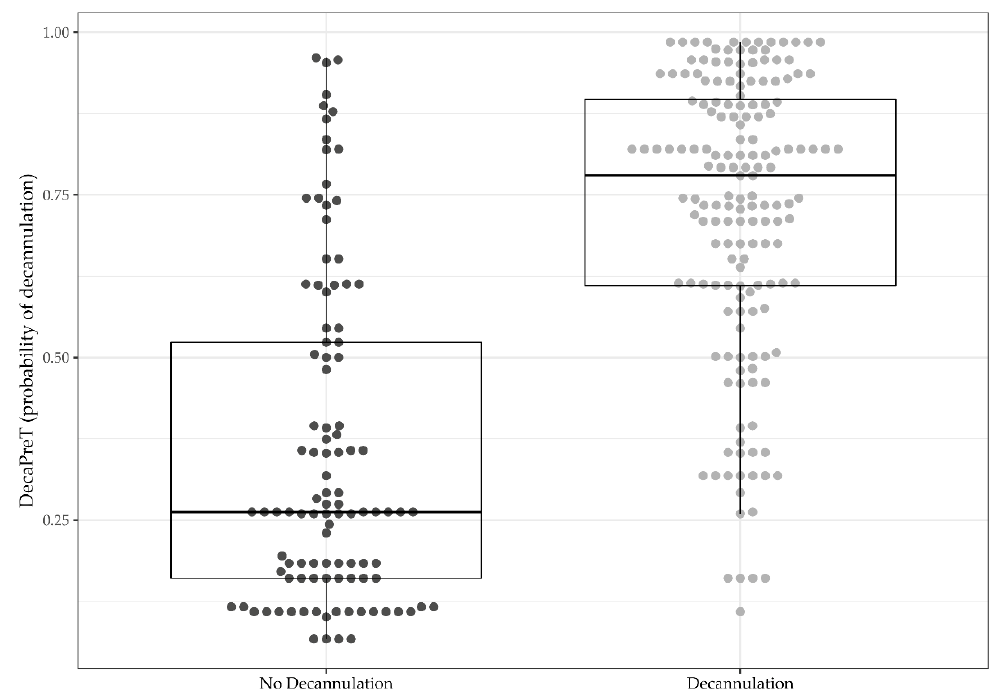
Figure 1. Distribution of probability of decannulation calculated by original DecaPreT equation between decannulated and not decannulated patients in our cohort.